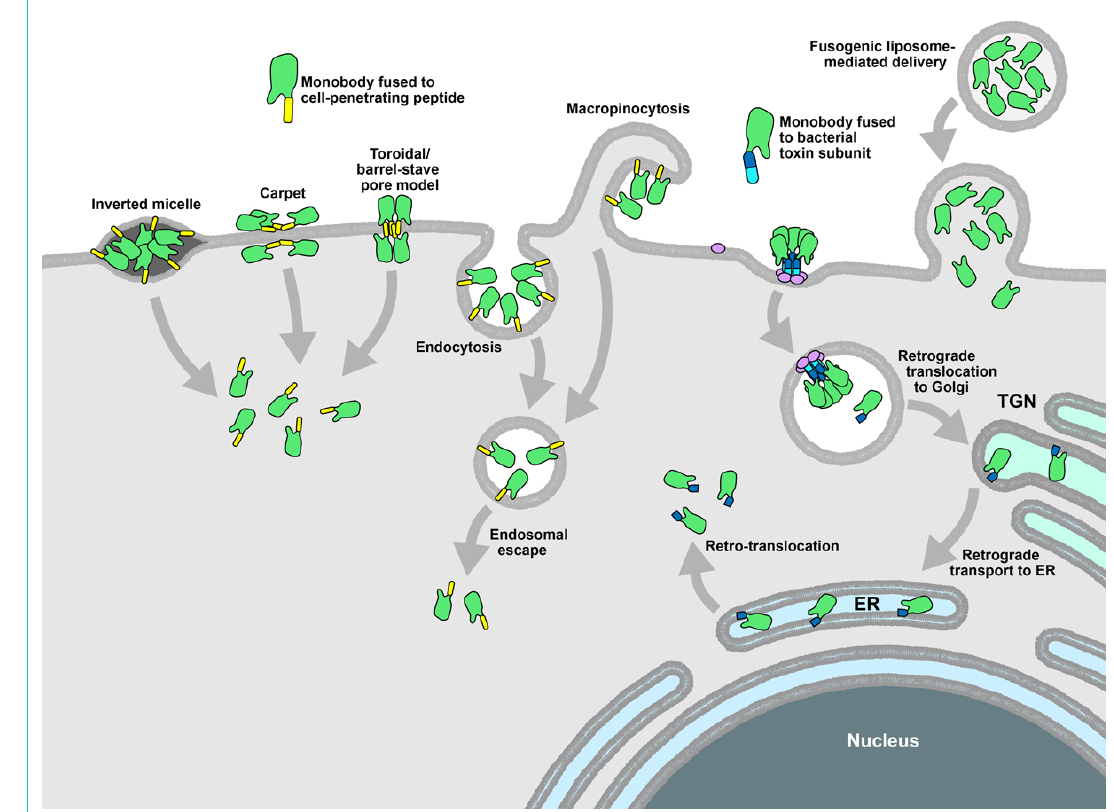
Figure 3: Overview of uptake routes and mechanisms for possible different approaches for monobody cellular